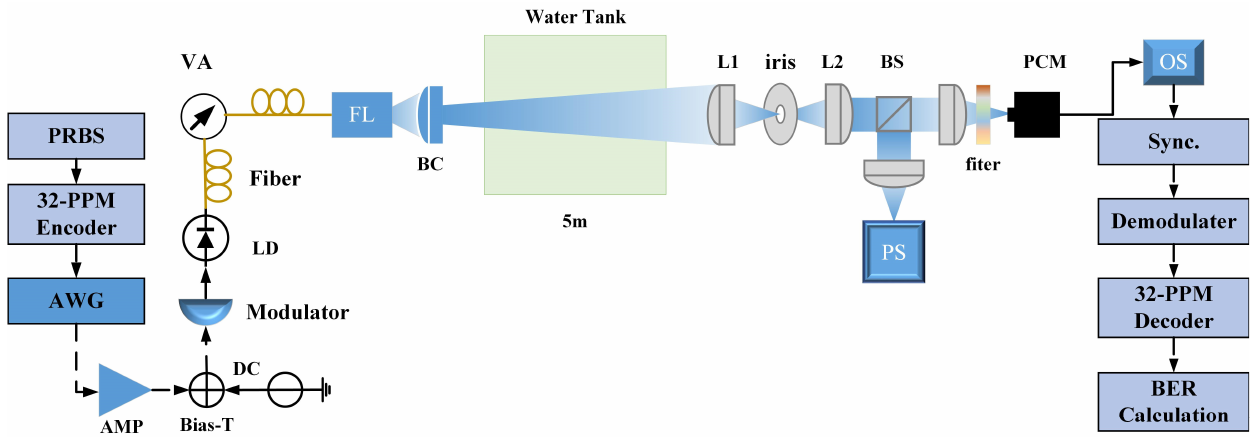
Figure 1. Schematic of the experimental setup. PRBS: pseudo-random bit sequence; AWG: arbitrary waveform generator; AMP: RF amplifier; LD: laser diode; VA: variable attenuator; FL: fiber launch; BC: beam collimator; BS: beam splitter; PCM: photon-counting module; PMD: power measurement device; OS: oscilloscope.